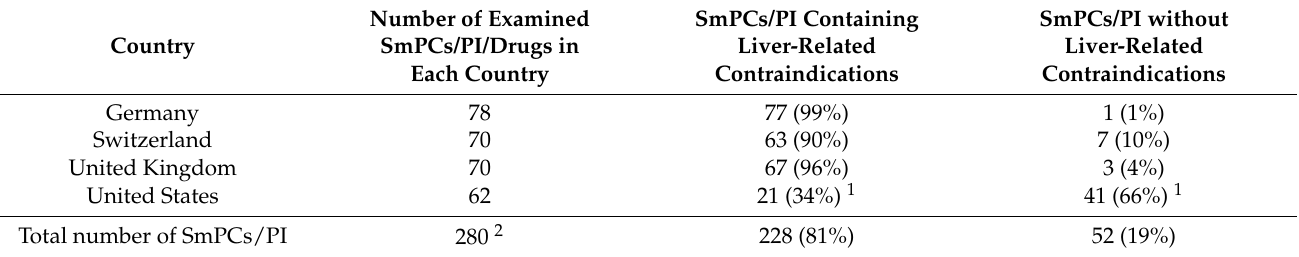
Table 3. Total number of SmPCs/PI ( n = 280) divided into those containing liver-associated contra- indications ( n = 228) and those not containing liver-associated contraindications ( n = 52) in the four chosen drug